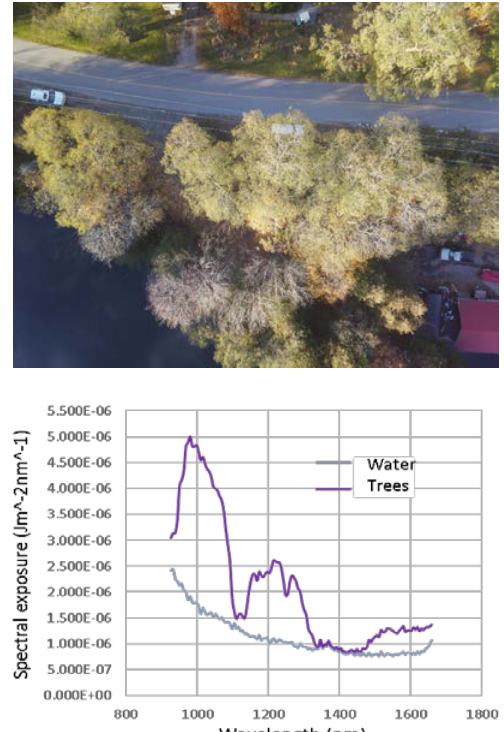
Figure 9. Spectral exposure signatures of Tree and Water